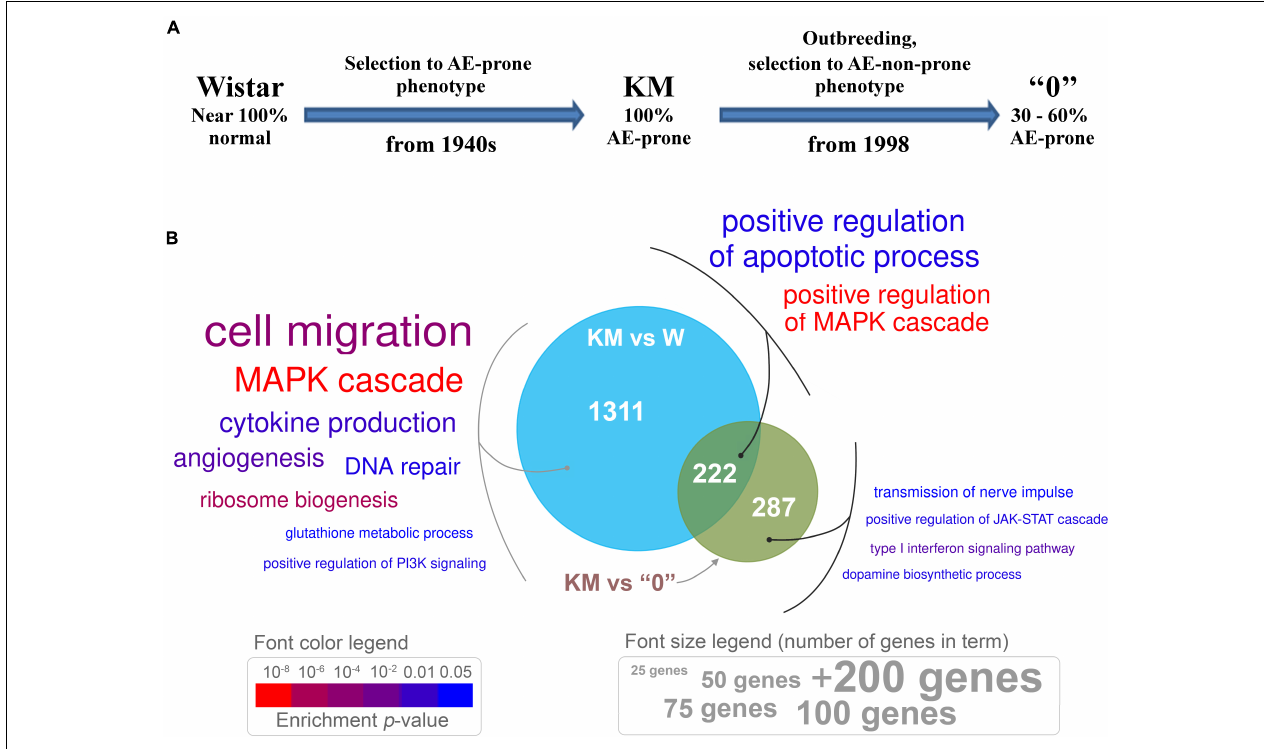
FIGURE 1 | (A) The sequential procedure for deriving the Krushinsky-Molodkina (KM) and “0” strains from the Wistar strain. (B) Venn diagram depicting differentially expressed genes (DEGs) between KM samples and those from W and “0” rats, which exhibit distinct genotypes. Genes with differential expression, p < 0.05, and expression changes greater than 1.5-fold (either up- or downregulated) were used for enrichment analysis. Enriched Gene Ontology (GO) terms are presented in colored text. The font size is proportional to the number of genes in a term (see the “font size legend”). Font color indicates the enrichment test p -value (see the “font color